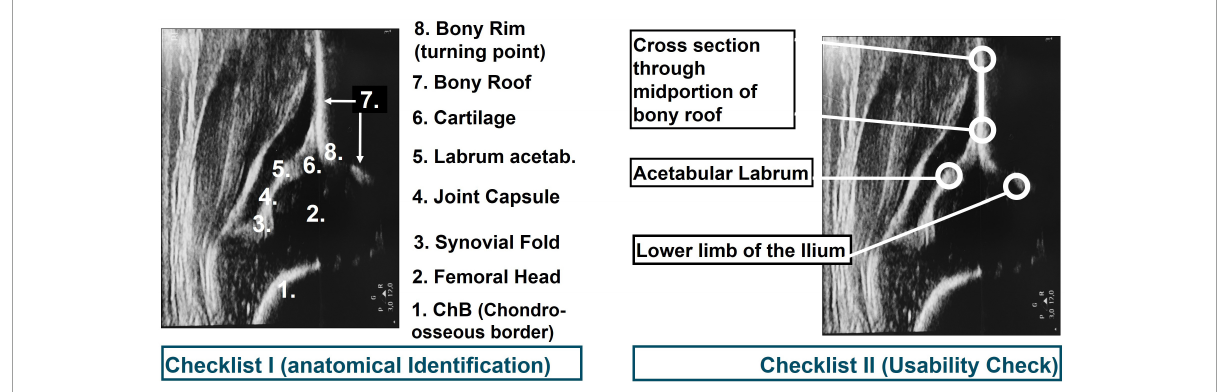
FIGURE2 Checklist for correct (left) anatomical identification and (right) standard plane according to the Graf method.